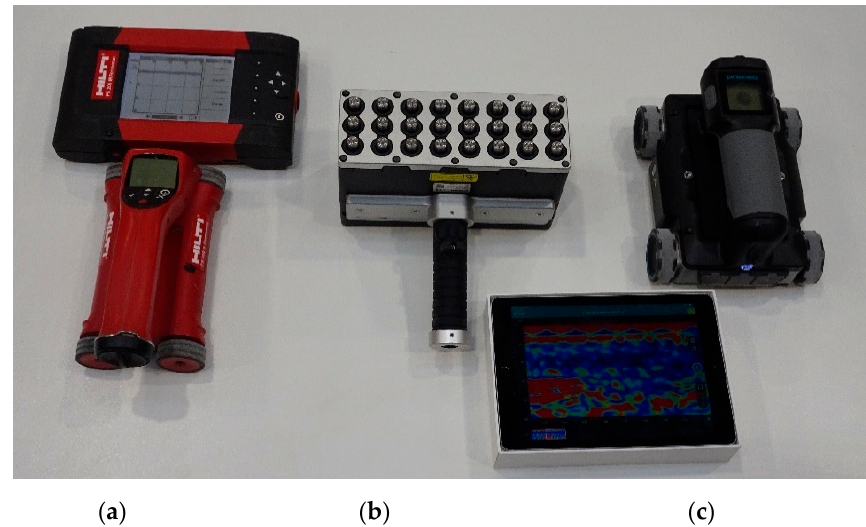
Figure 7. Instruments used in the tests, ( a ) electromagnetic scanner, ( b ) ultrasonic tomography, ( c ) radar scanner.